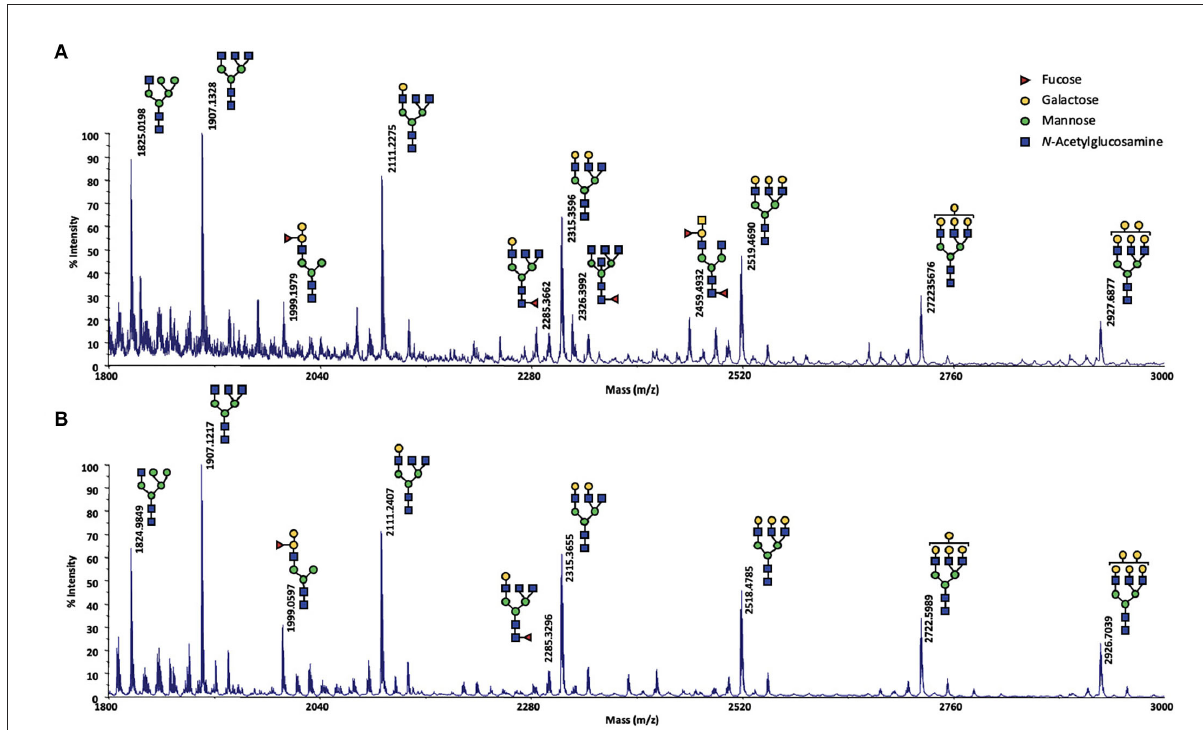
FIGURE4 MALDI-TOF spectrum of permethylated N-glycans extracted from olfactory secretome of the CTRL2 ewe during the sexual activity period (A) in 2017; (B) in 2018. N-glycans were detected as sodium adduct ions [M + Na] + over a mass range of m/z 1,800–3,000. The presence of structural isomers cannot be excluded. Structural schemes of glycans are depicted following the CFG notation: N -acetylglucosamine (blue square), fucose (red triangle), mannose (green circle), galactose (yellow